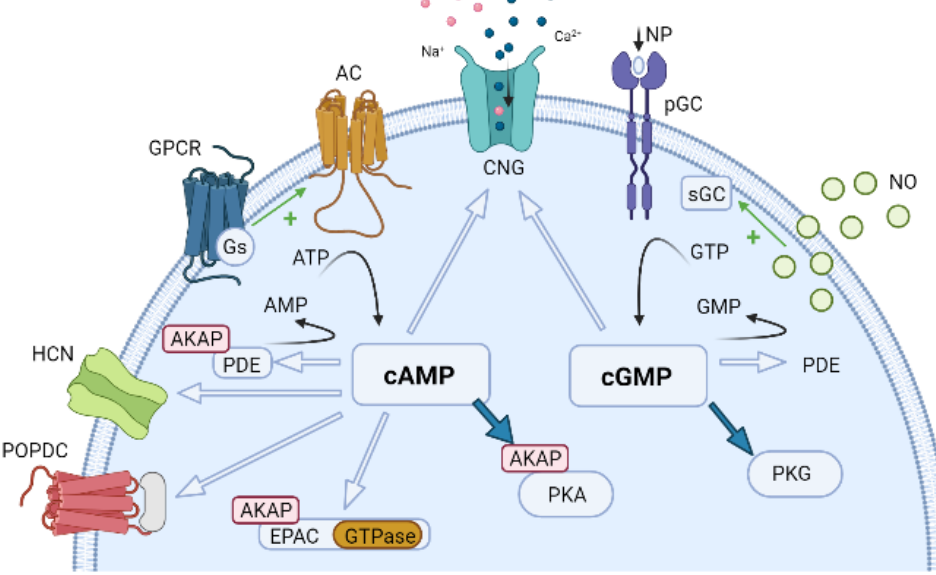
Figure 3. Cyclic nucleotide effectors in the vascular smooth muscle (created with biorender.com). cAMP is synthetized by transmembrane adenylyl cyclases (AC, activated by Gs proteins) and acts mainly by protein kinase A (PKA) and by an exchange protein directly activated by cAMP (EPAC) and Popeye domain-containing proteins (POPDC). cGMP is synthetized by particulate GC (activated by natriuretic peptides, NP) and by soluble GC (activated by nitric oxide, NO) and acts mainly by protein kinase G (PKG). Finally, both cyclic nucleotides activate cyclic nucleotide-gated (CNG) channels and modulate specific cyclic nucleotide phosphodiesterases (PDEs).